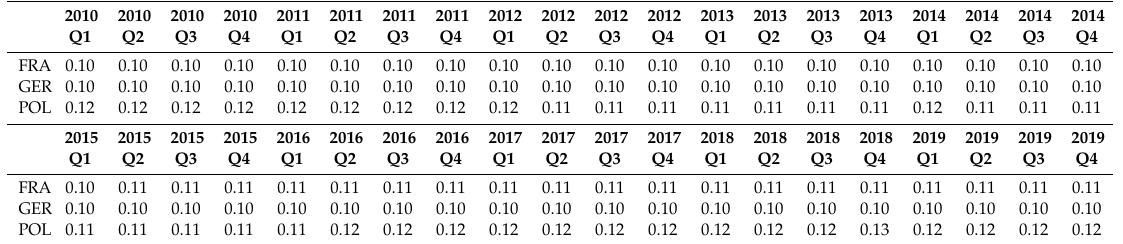
Table 6. Average tax rate—indicator TN , own work, source: Eurostat